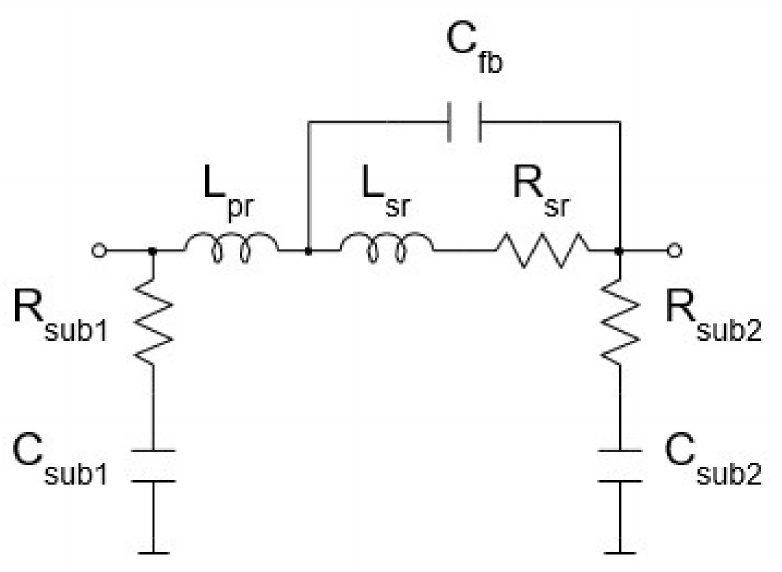
Figure 7. Equivalent circuit of a circular spiral inductor. The calculated parameters of models of several inductors are given in Table 2. Table 2. Parameters of equivalent circuit models of circular spiral inductors.